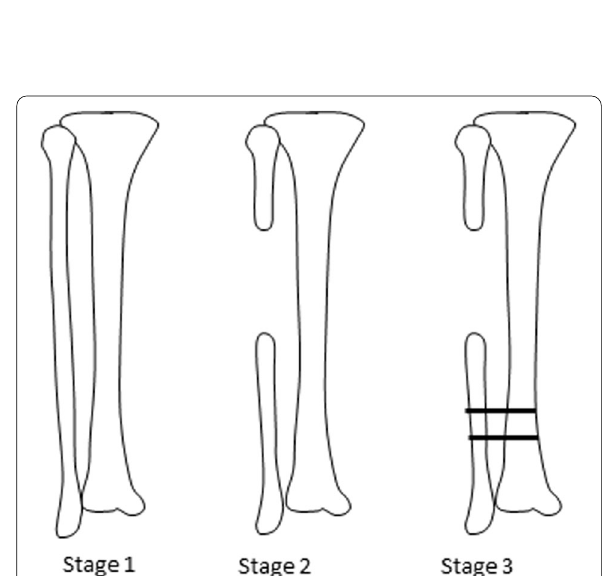
Fig. 2 The three phases of the procedure with fibular resection and